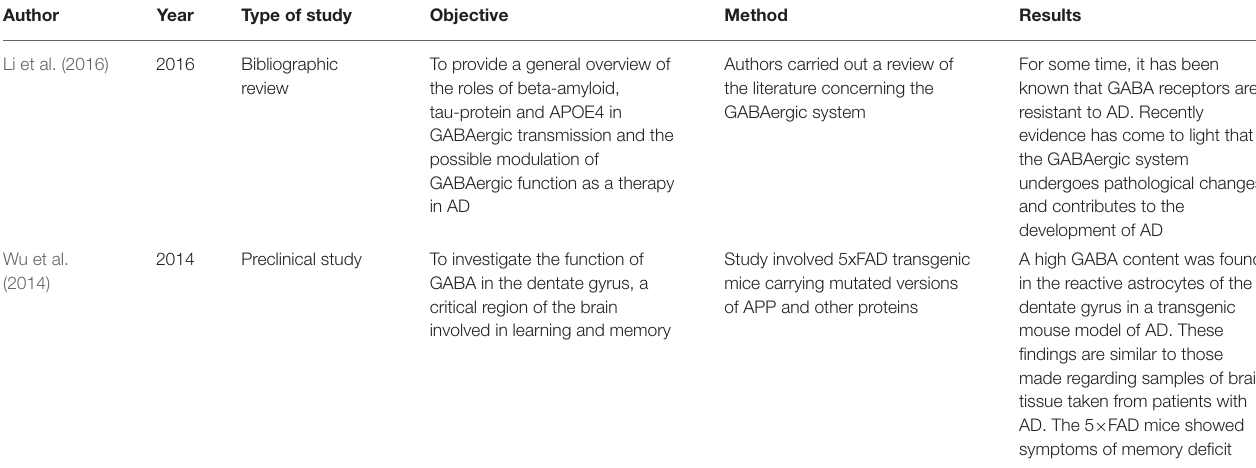
TABLE 4 | Microbiota and gamma-aminobutyric acid